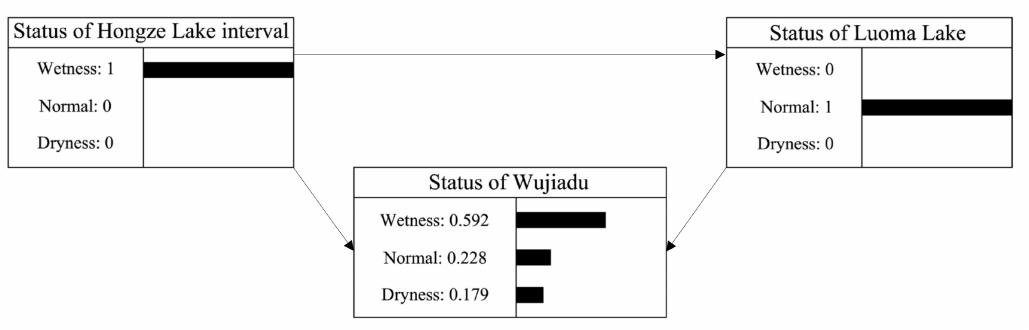
Figure 11. The Bayesian network diagram when the statuses of Hongze Lake interval and Luoma Lake are wetness and normal (in 2017 and 2018).